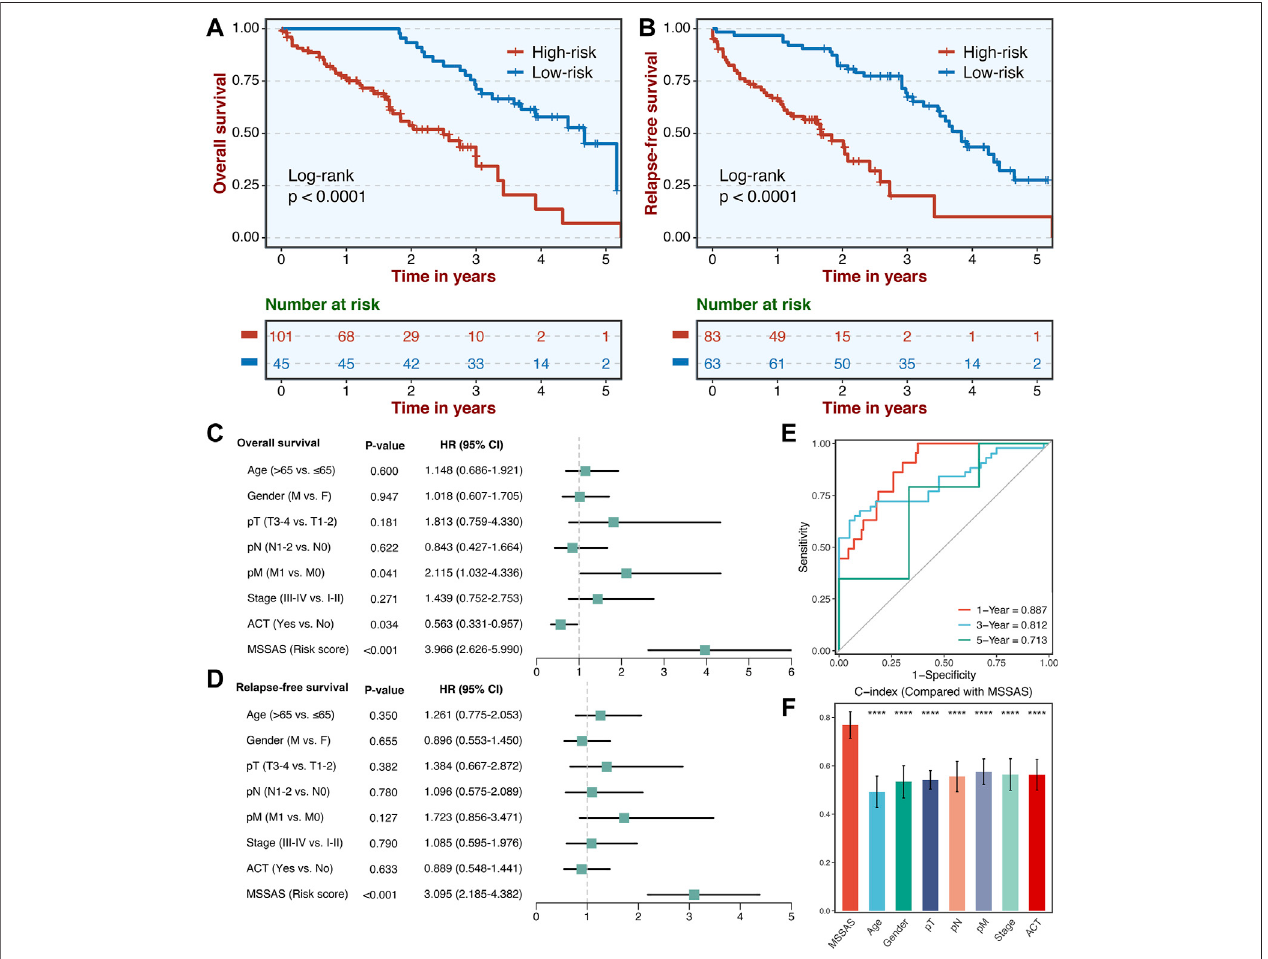
FIGURE8| ValidationofMSSASinourclinicalcohort.Kaplan – MeiercurvesofOS (A) andRFS (B) accordingtotheMSSAS.MultivariateCoxregressionanalysisof MSSASforOS (C) andRFS (D) . (E) Time-dependentROCanalysisforpredictingOSat1,3,and5 years. (F) .TheperformanceofMSSASwascomparedwithcommon clinical and molecular variables in predicting